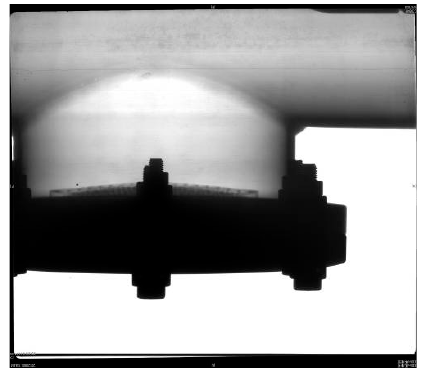
Figure 18. Adsorbent cover made of general plastics.